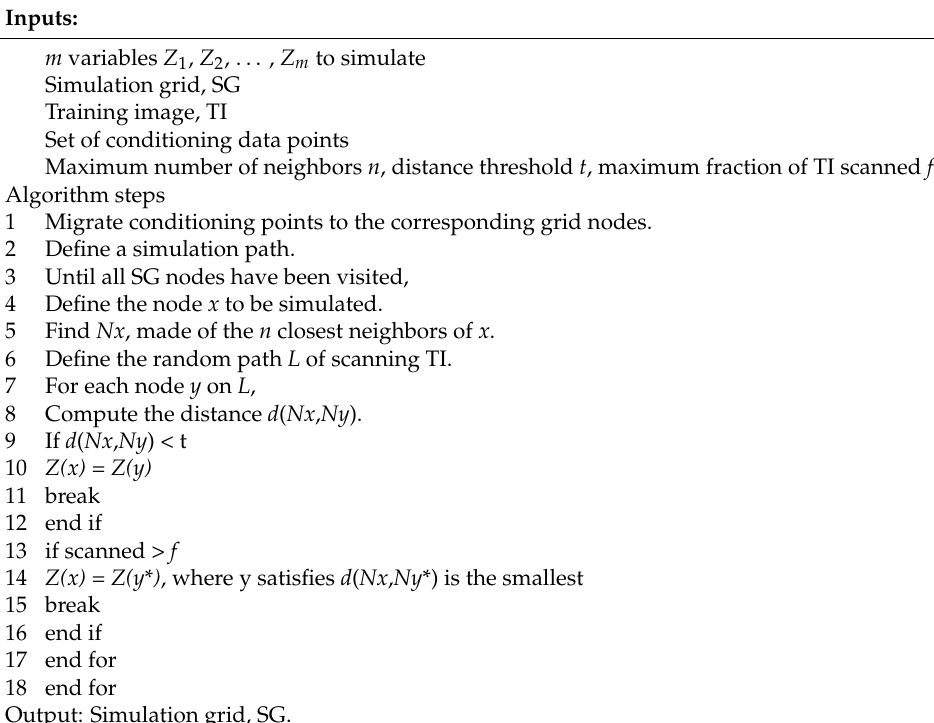
Table 1. The direct sampling algorithm